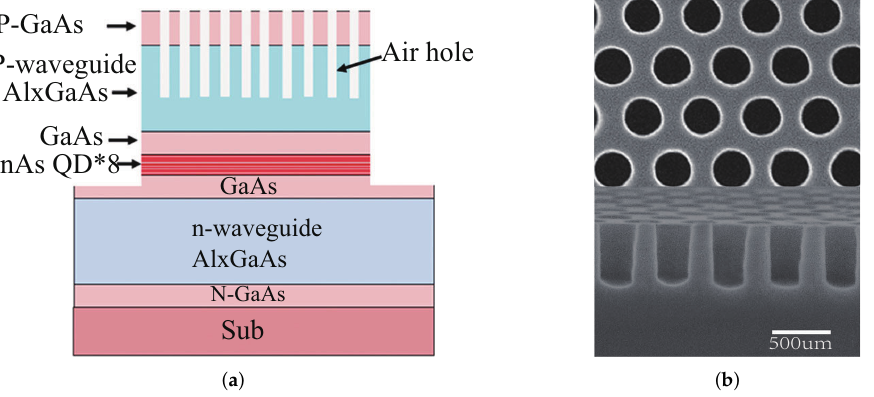
Figure 6. ( a ) Cross-sectional schematic of the PCSEL; ( b ) top-view SEM image of the 2D PC and side-view SEM image of the 2D PC [53].